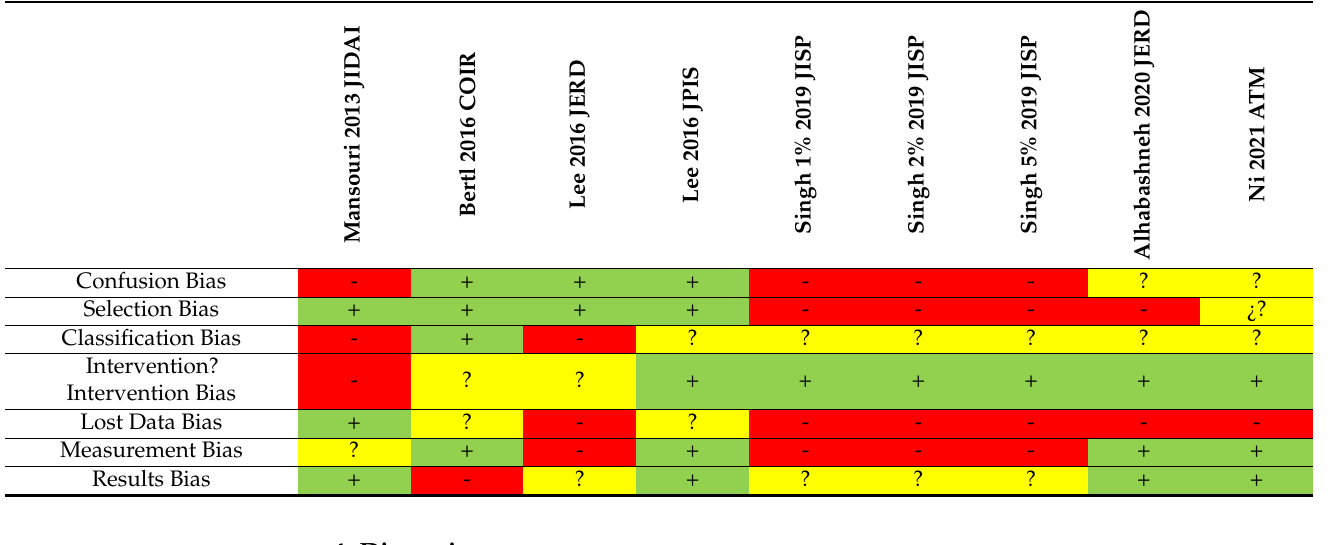
Table 2. Assessing risk of bias in included studies. All studies have moderate to high risk of bias. Low risk of bias = green (+), unclear risk of bias = yellow (¿?), high risk of bias = red